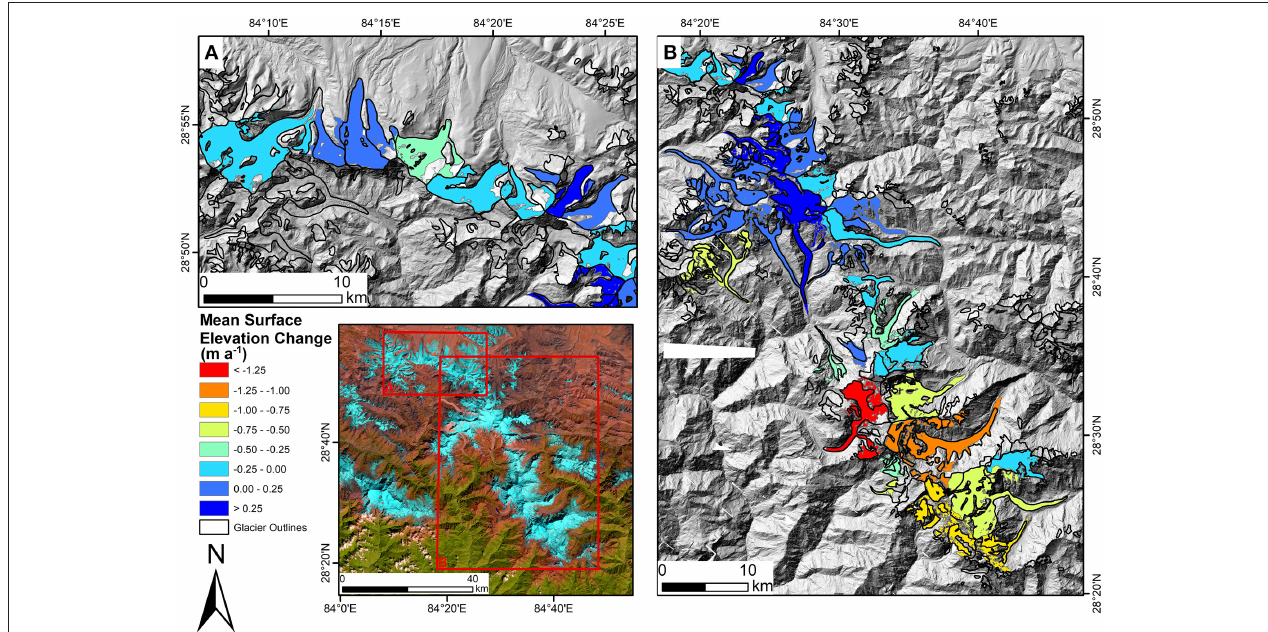
FIGURE 3 | Mean annual surface elevation change per glacier between 2000 and 2013. Changes are shown for the northern glaciers (A) and southern glaciers (B) . The background hillshade is based on the 2013 SETSM DEM.